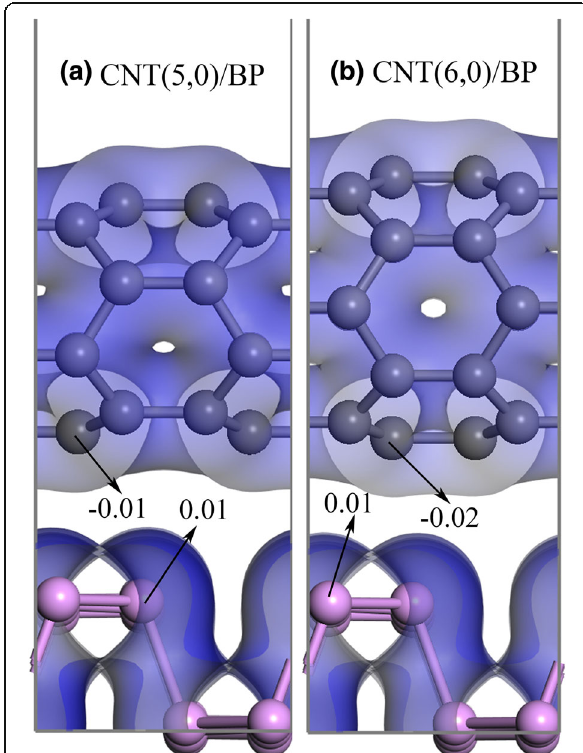
Fig. 6 Charge distribution maps of ( a ) CNT(5,0)/BP and ( b ) CNT(6,0)/ BP with an isovalue of 0.005 e/Å 3 . Gray and pink spheres represent C and P atoms